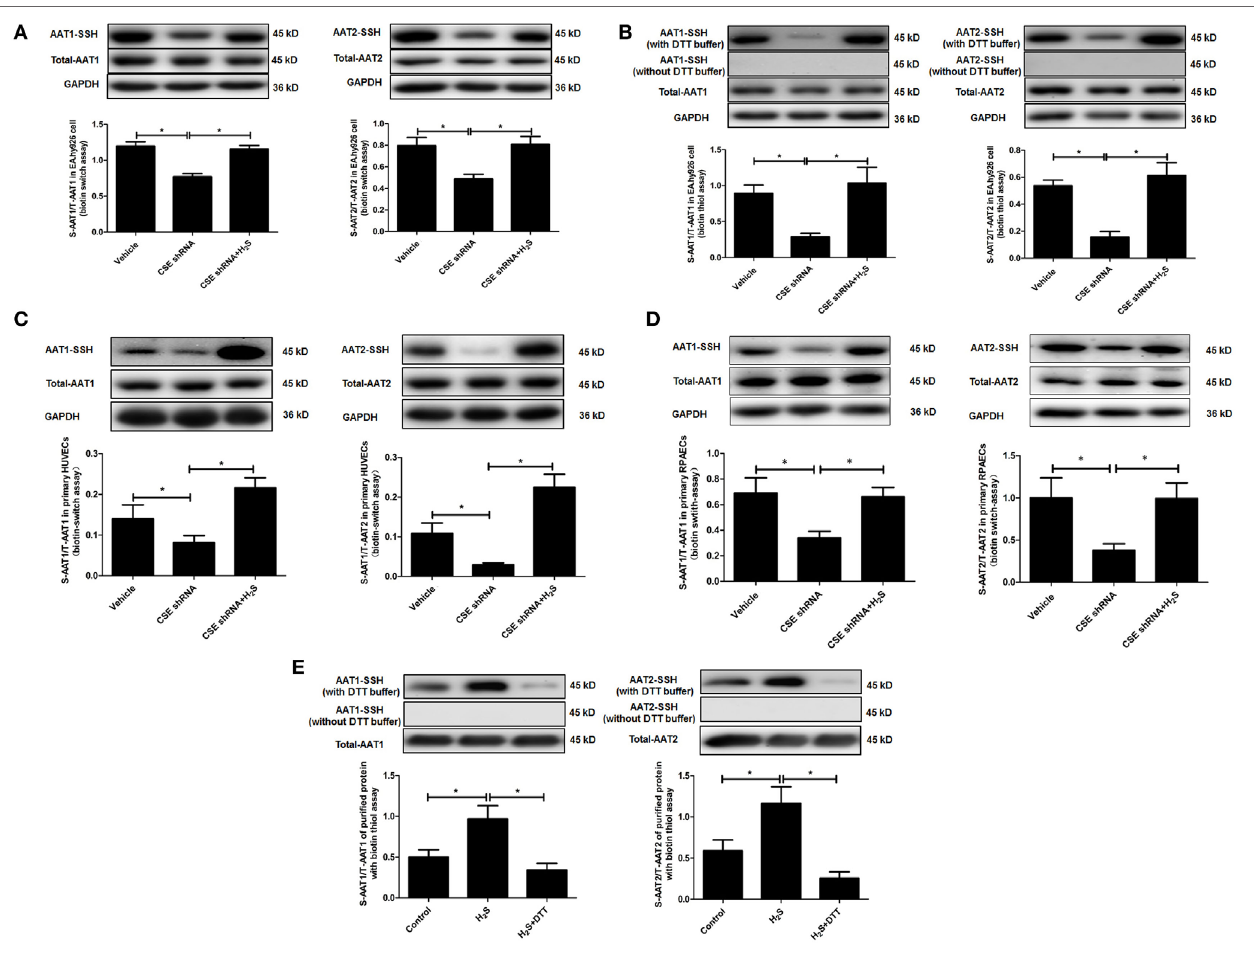
FigUre 4 | Endogenous H 2 S induced the sulfhydration of aspartate aminotransferase (AAT) in the endothelial cells and purified protein. (a) Sulfhydration of AAT1 and AAT2 in the EA.hy926 cell detected by biotin switch assay. (B) Sulfhydration of AAT1 and AAT2 in the in the EA.hy926 cell detected by biotin thiol assay. (c) Sulfhydration of AAT1 and AAT2 in the primary human umbilical vein endothelial cells (HUVECs) detected by biotin switch assay. (D) Sulfhydration of AAT1 and AAT2 in the primary rat pulmonary artery endothelial cells (RPAECs) detected by biotin switch assay. (e) Sulfhydration of purified AAT1 and AAT2 proteins from pig heart detected by biotin thiol assay. * P < 0.05. Data are expressed as means ± SEM, and all experiments were performed independently for at least three